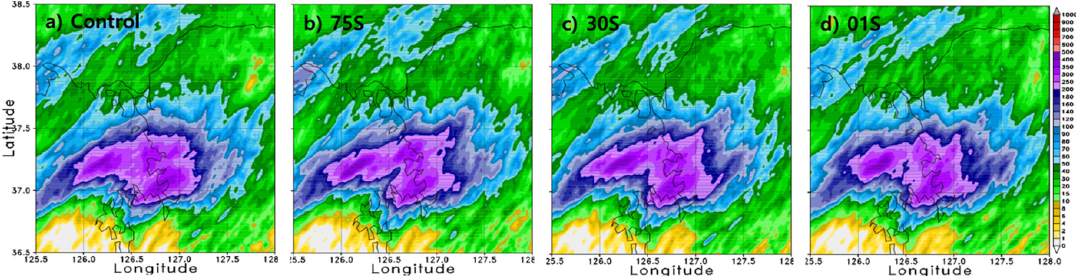
Figure 7. Accumulated daily rainfall on 27 July 2011 for ( a ) Control; ( b ) 75S; ( c ) 03S and ( d ) 01S.